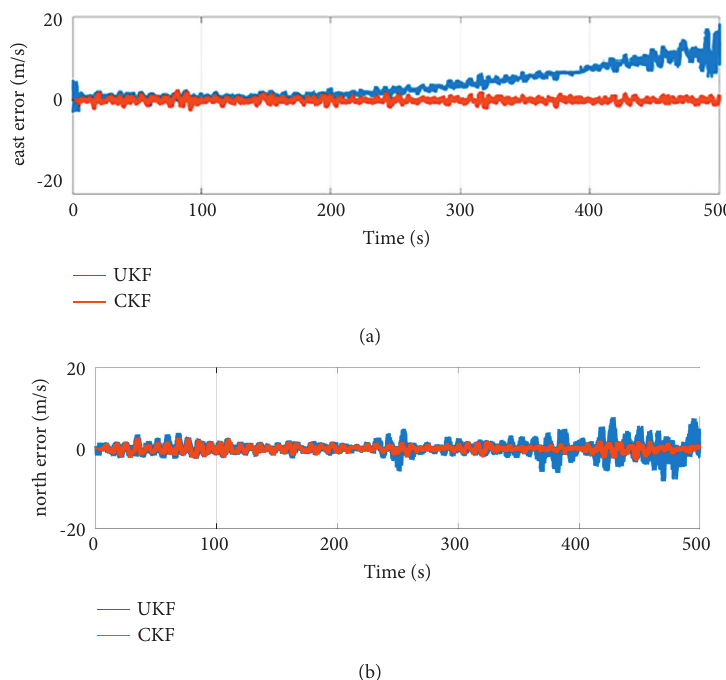
Figure 4: Estimation error in velocity (east and